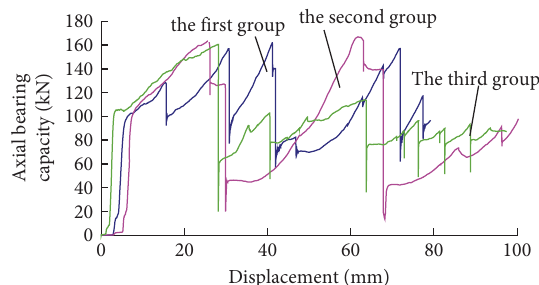
Figure 2: U -shape lap section of the axial bearing capacity of the force-displacement relation curve.